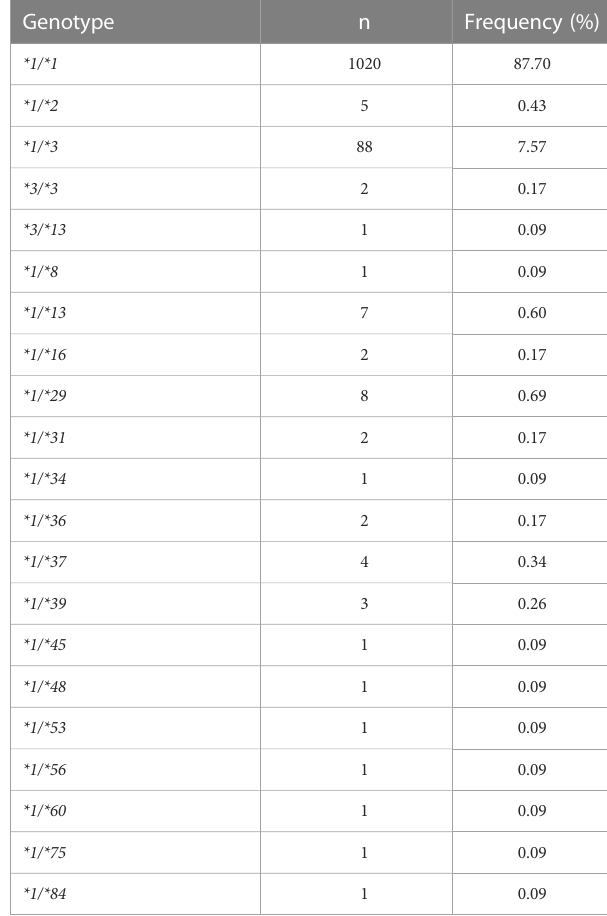
TABLE 4 Genotype frequencies of CYP2C9 allelic variants in 1163 Chinese Han